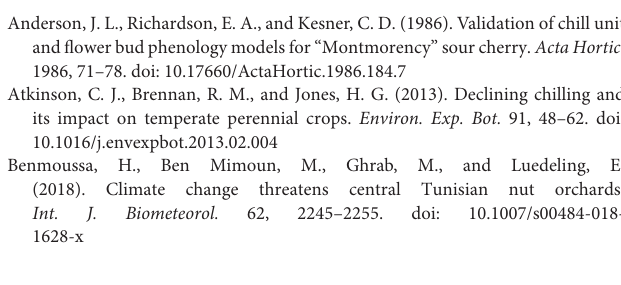
Supplementary Figure 1 | Correlation between mean accumulated portions and chill units for the current scenario in all the weather stations. Supplementary Figure 2 | Correlation between mean accumulated GDH for Anderson and Richardson models for the current scenario in all the weather